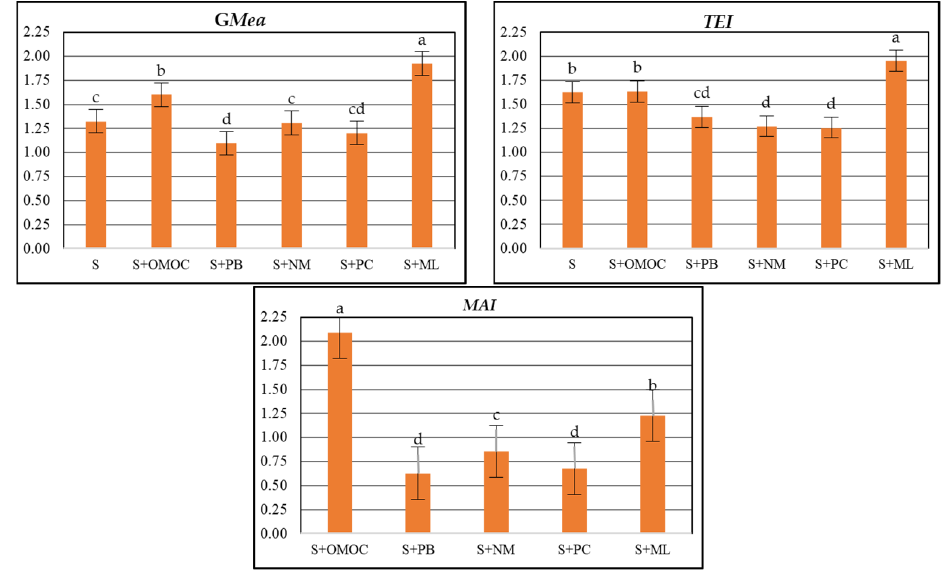
Figure 4. Index of soil enzymes: G Mea , TEI and MAI. Bars with the same small letter represent no significant differences at p = 0.05.